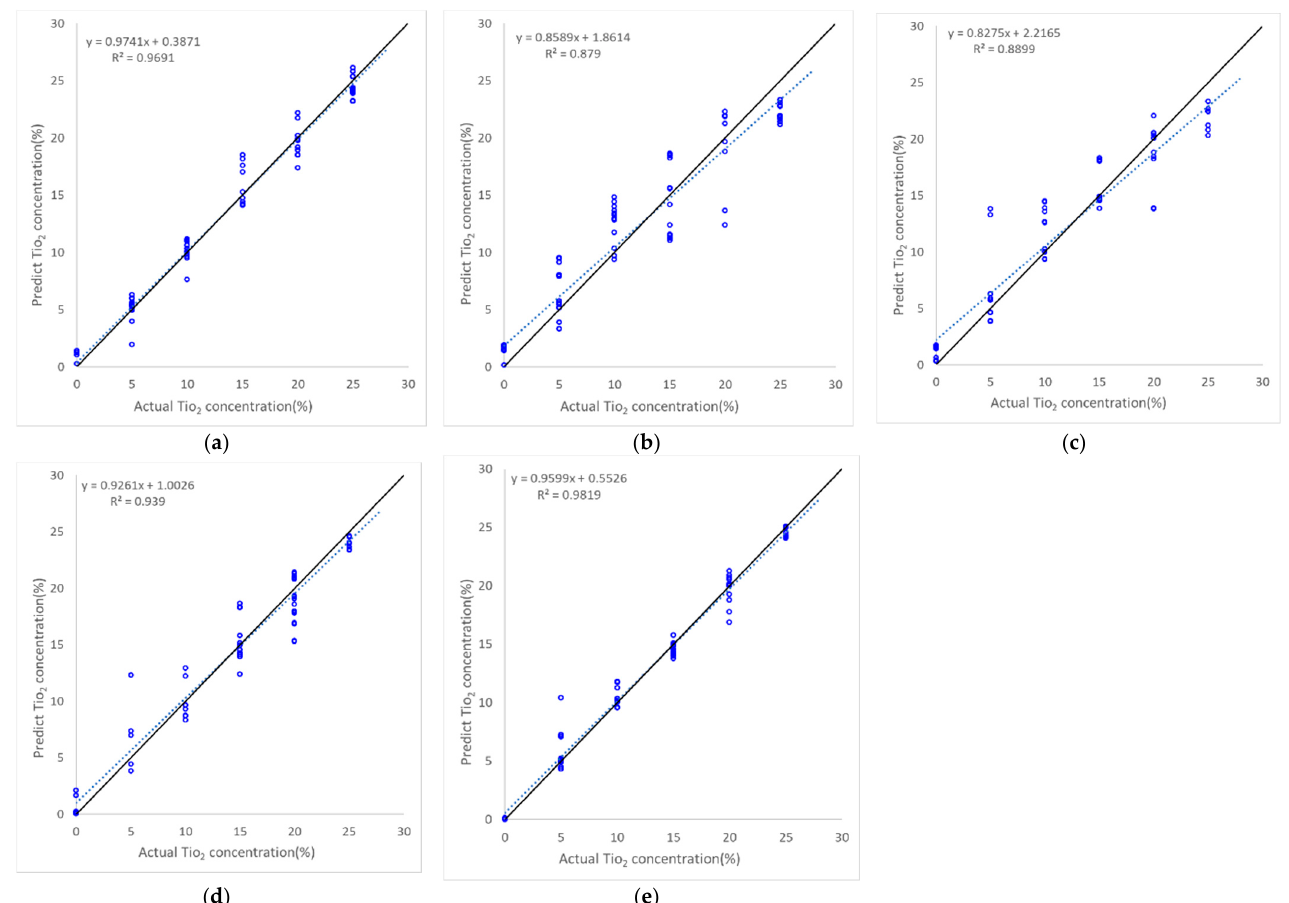
Figure 11. Bar graphs representing the TiO 2 estimation performance of the five machine learning algorithms when applied to the training/validation dataset (Dataset I).